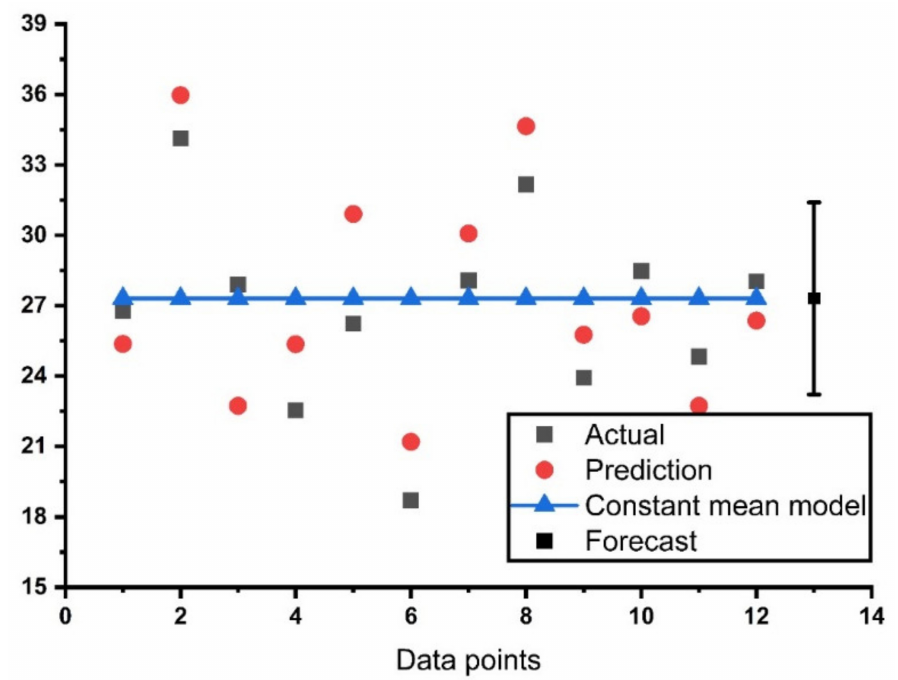
Figure 7. Distribution of constant mean model result.